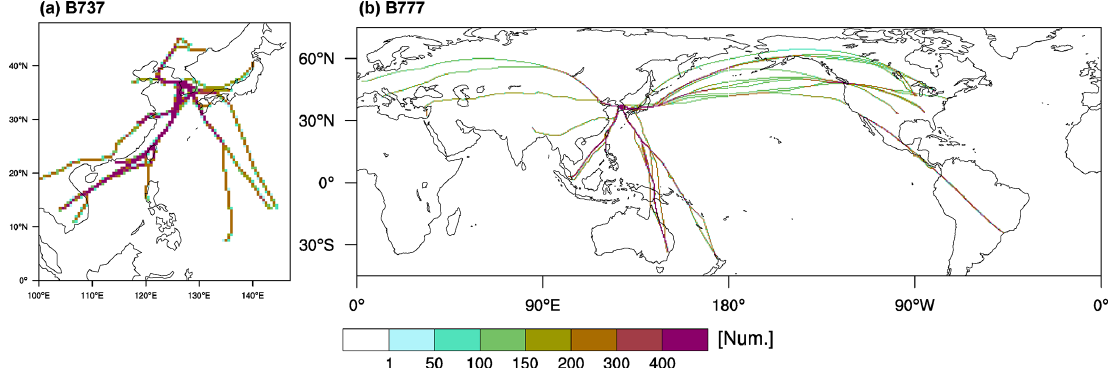
Figure 1. The horizontal distribution of the number of (a) B737 and (b) B777 aircraft data at altitudes above 15kft, accumulated within a 0.5 ◦ × 0.5 ◦ horizontal grid box for the 12 months from January to December